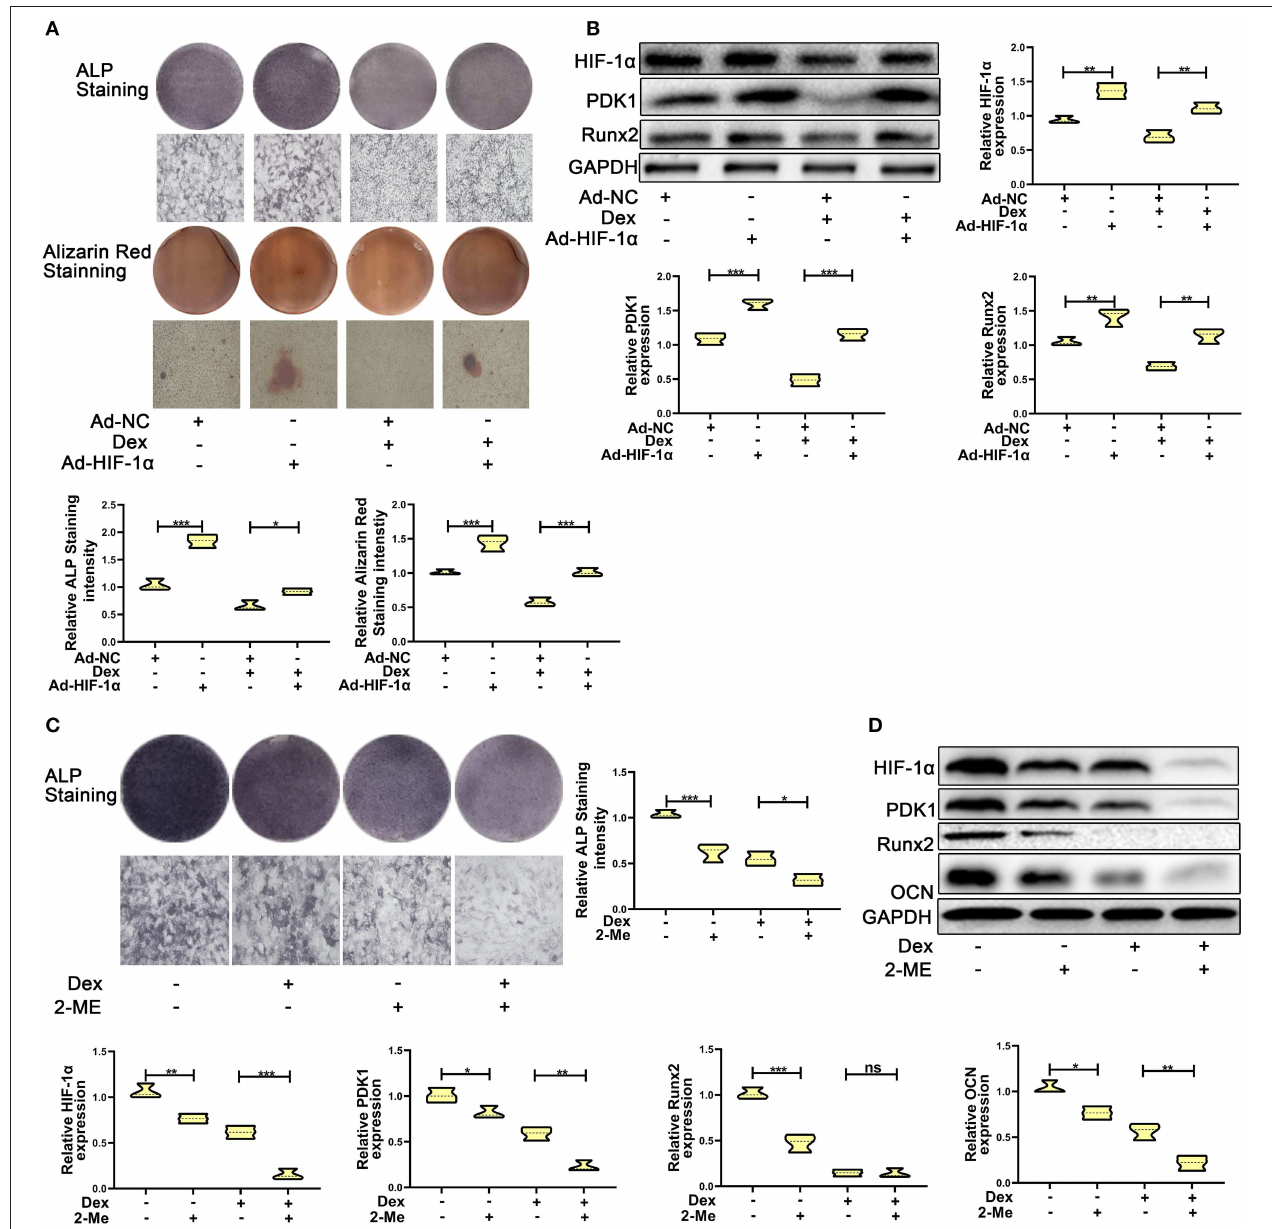
FIGURE 2 | HIF-1 α mediated dexamethasone-induced osteogenic inhibition of osteoblasts via regulating PDK1 expression. (A) Osteogenic ability was confirmed by ALP and Alizarin red staining in MC3T3-E1 cells treated with Ad-NC, Ad- HIF-1 α + dexamethasone, Ad-NC + dexamethasone and Ad-HIF-1 α + dexamethasone, respectively. Scale Bar = 20 µ m. (B) The protein expression levels of HIF-1 α , PDK1, Runx2, and GAPDH were detected by western blotting in MC3T3-E1 cells treated with Ad-NC, Ad-HIF-1 α + dexamethasone, Ad-NC + dexamethasone and Ad-HIF-1 α + dexamethasone, respectively. (C) Osteogenic ability was confirmed by ALP staining in MC3T3-E1 cells treated with empty vector, dexamethasone, 2-ME and dexamethasone + 2-ME, respectively. Scale Bar = 20 µ m. (D) The protein expression levels of HIF-1 α , PDK1, Runx2, OCN, and GAPDH were detected by western blotting in MC3T3-E1 cells treated with empty vector, dexamethasone, 2-ME and dexamethasone + 2-ME, respectively. Differences were considered as statistically significant when p < 0.05. *** p < 0.001, ** p < 0.01, * p < 0.05.